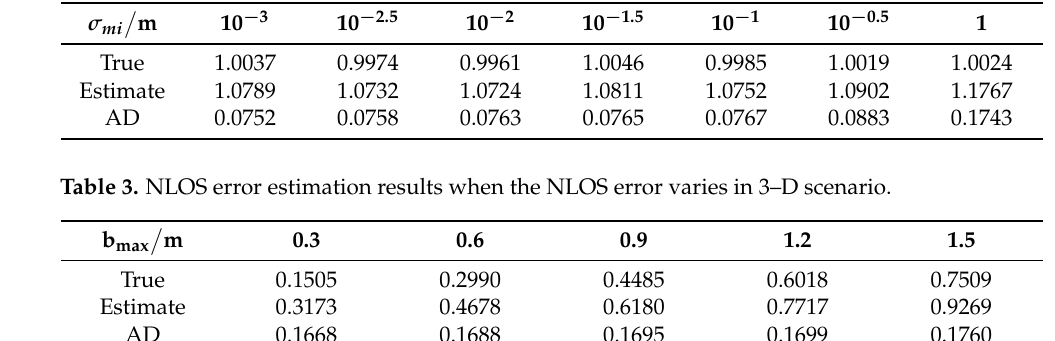
Table 2. NLOS error estimation results when measurement noise varies in the 3–D